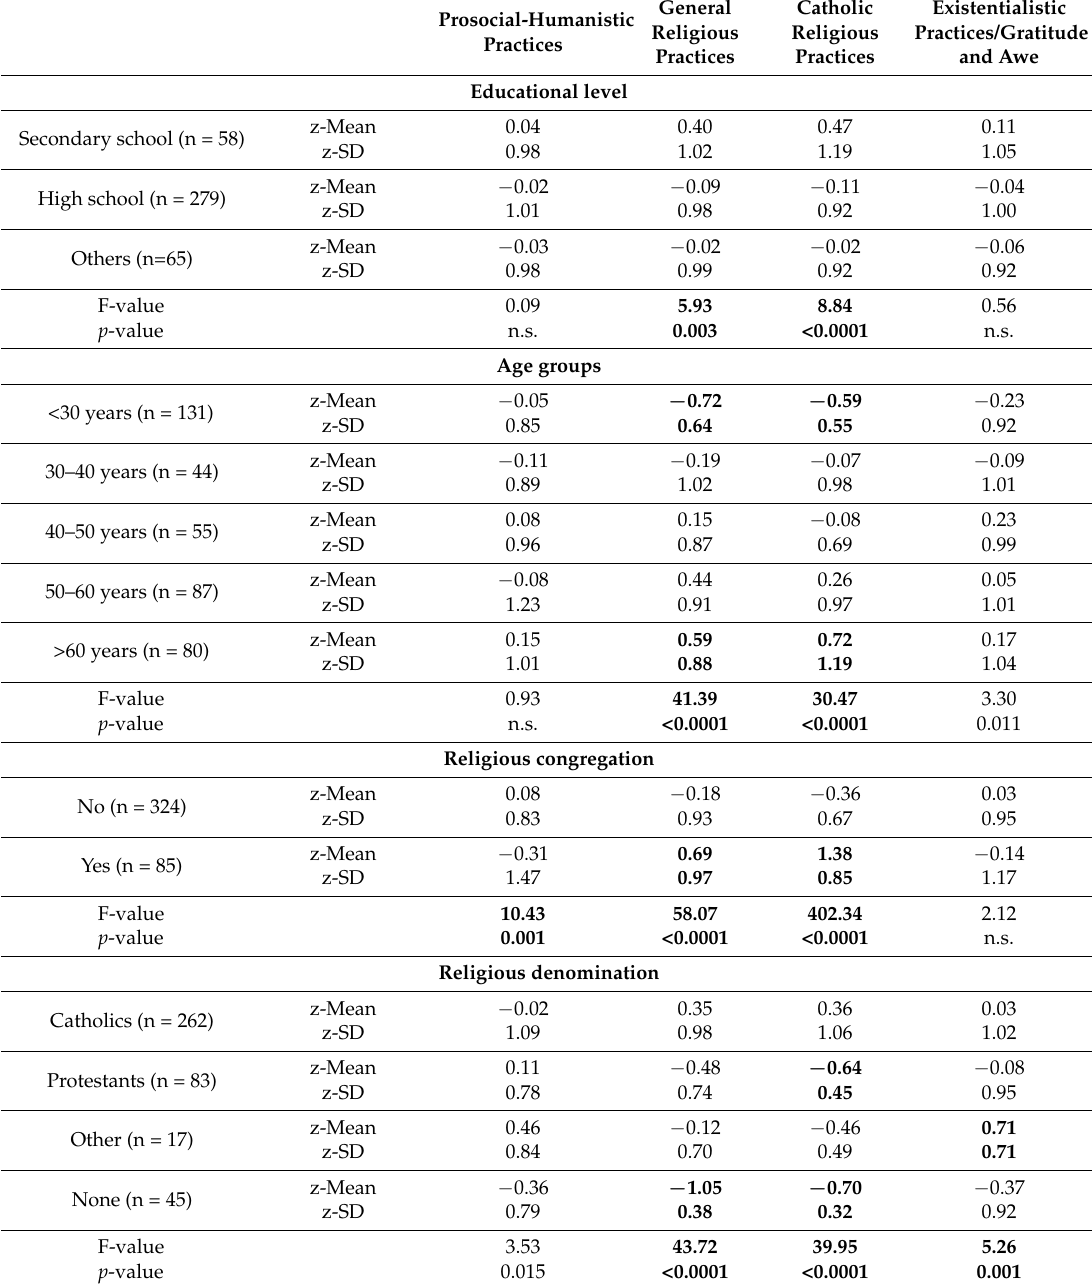
lower on PHP; with respect to ExGA there were no significant differences. While it is in line with the expectations that persons without any religious denomination score low on GRP and CRP, they also had low scores on PHP and ExGA (Table